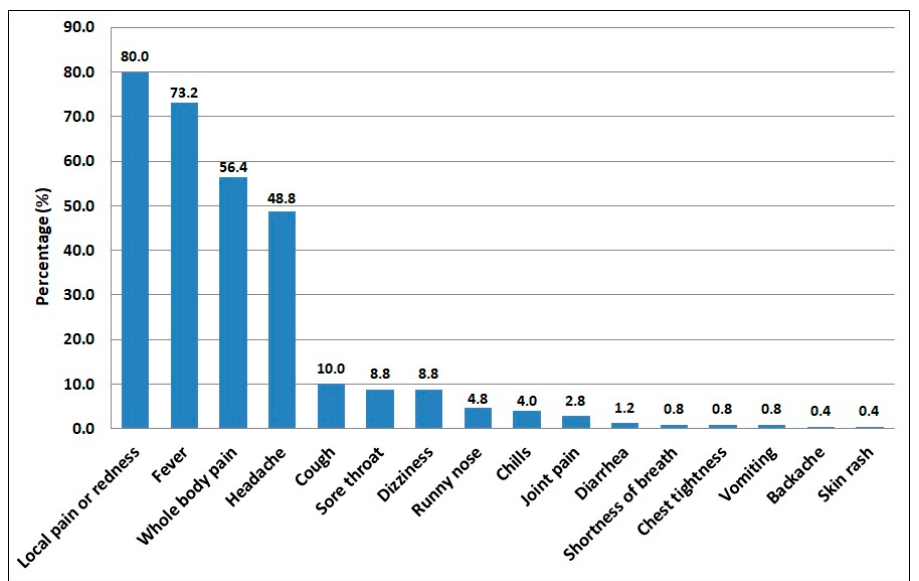
Figure 2. The frequency of COVID-19 vaccine side-effects reported among the participants ( n = 250). The distribution of different side-effects according to participants’ gender was investi- gated among the HCWs who developed COVID-19 post-vaccination side-effects (Table 2). The results showed that female HCWs had a significantly higher frequency of side-effects of dizziness (11.9% vs. 3.3%; χ 2 = 5.236; p = 0.022) and chills (6.2% vs. 0.0%; χ 2 = 5.859; p = 0.015) compared to male HCWs. On the other hand, the male HCWs had a significantly higher frequency of whole-body pain/fatigue (67.8%, 61/90) compared to their female peers (50.0%, 80/160) ( χ 2 = 7.403; p = 0.007). Nonetheless, these significant differences were not retained when the Bonferroni–Holm adjustment was applied. Table 2. Distribution of COVID-19 vaccine side-effects reported among the healthcare worker partici- pants according to gender ( n =